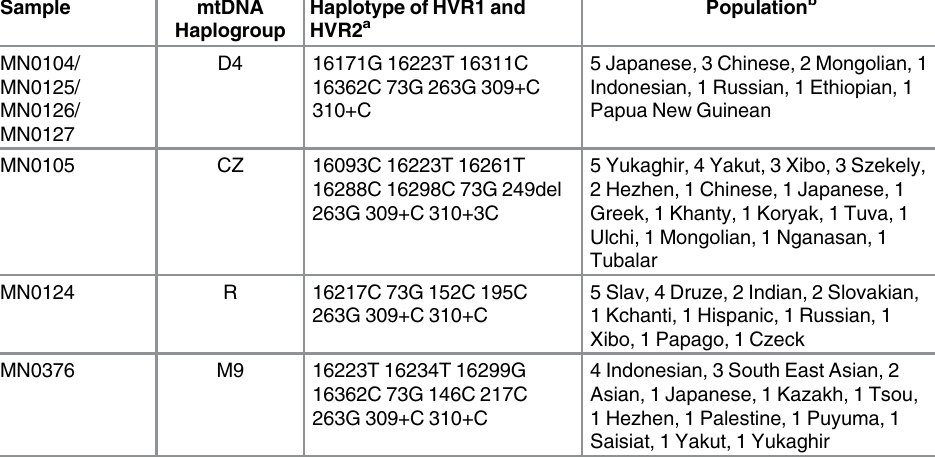
Table 5. Geographic distribution of the modern-day individuals with the same mtDNA haplotypes as those of the Tavan Tolgoi bodies. Sample mtDNA Haplotype of HVR1 and Haplogroup HVR2